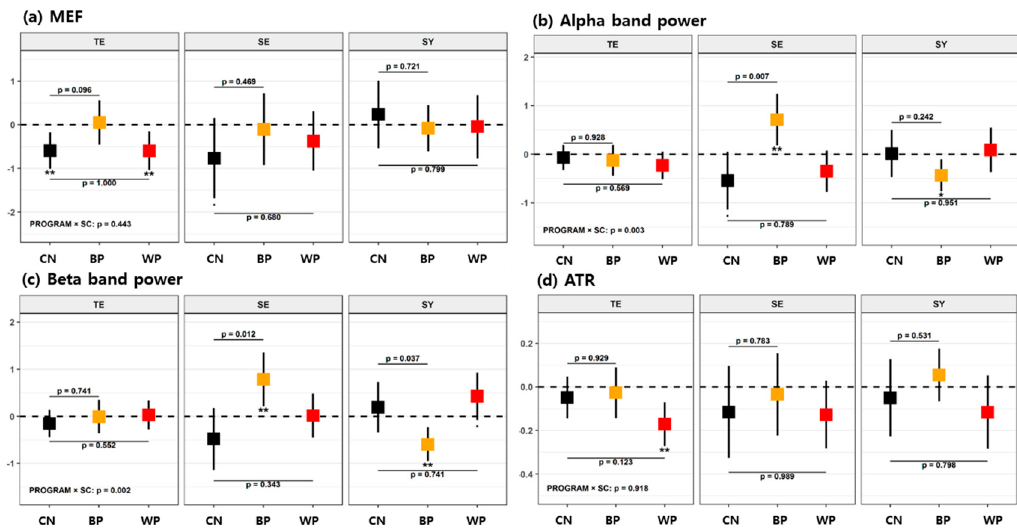
Figure 3. Mean changes in EEG variables after each of the forest therapy programs (FTPs) according to SC types for ( a ) median frequency (MEF), ( b ) P α , ( c ) P β , and ( d ) alpha/theta ratio (ATR). Error bars represent 95% confidence intervals (CIs) for the mean changes. Asterisks below the lower confidence limits indicate the magnitude of statistical significance for the mean changes within each program group value (· p < 0.1, * p < 0.05, ** p < 0.01, *** p < 0.001). The p -values noted in the figure are obtained from the multiple comparisons (BP vs. CN and WP vs. CN) for the group difference in the mean changes between the two groups. Dunnett’s method was used to adjust the type I error. Mean changes are adjusted for sex, age, education level, Mini Mental-Status Examination (MMSE), and daily activity hours.